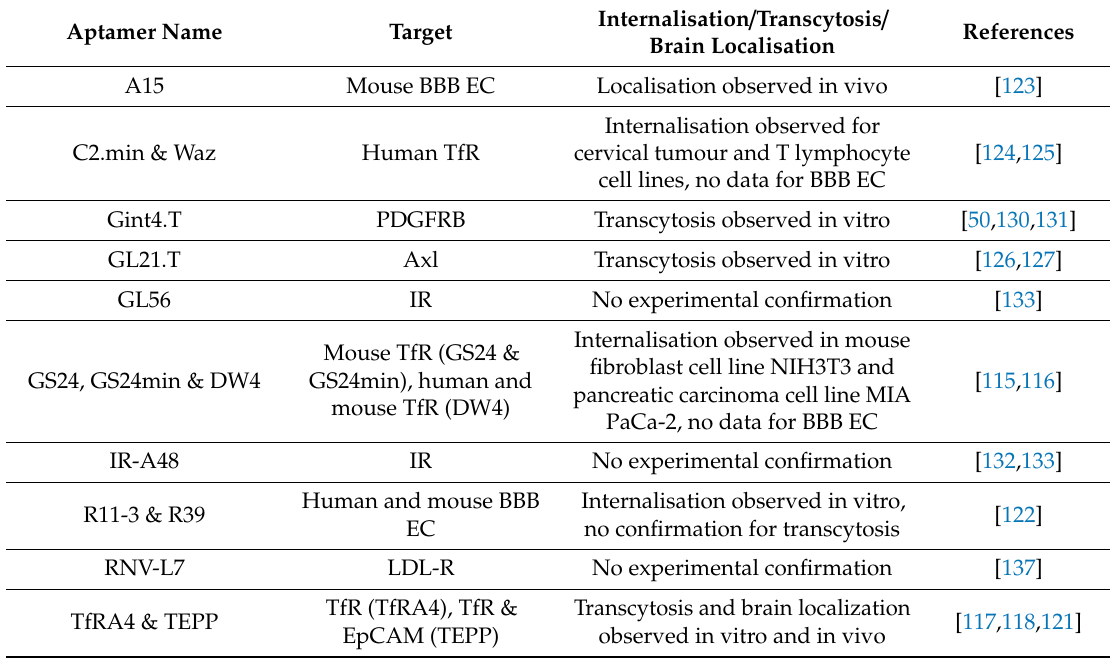
Table 2. Studies that have been completed on aptamers with the potential to assist in BBB transcytosis of